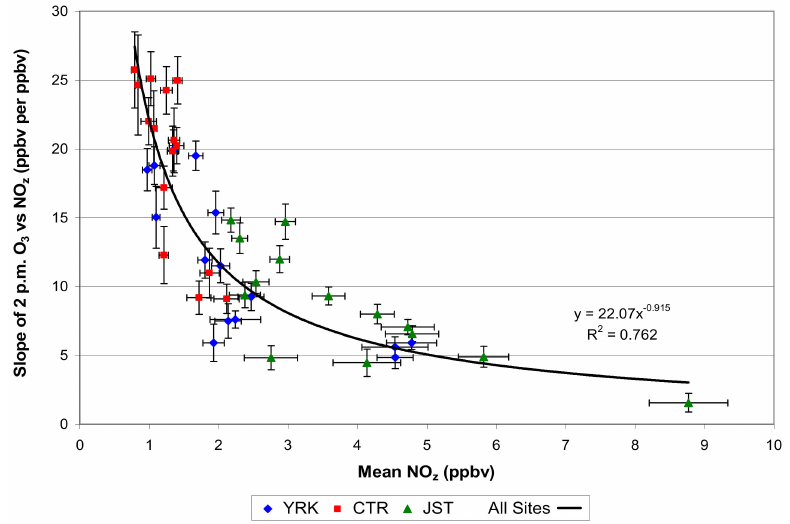
Figure 6. Variation of a measure of O 3 production efficiency with NO z . JST is an urban site in Atlanta, YRK is a suburban Atlanta site, and CTR (Centreville) is a rural remote site. Urban conditions reflect relatively low OPE, while rural cases show much higher OPE, tending to offset the effect of ozone concentrations with NO y . (From Blanchard and Hidy